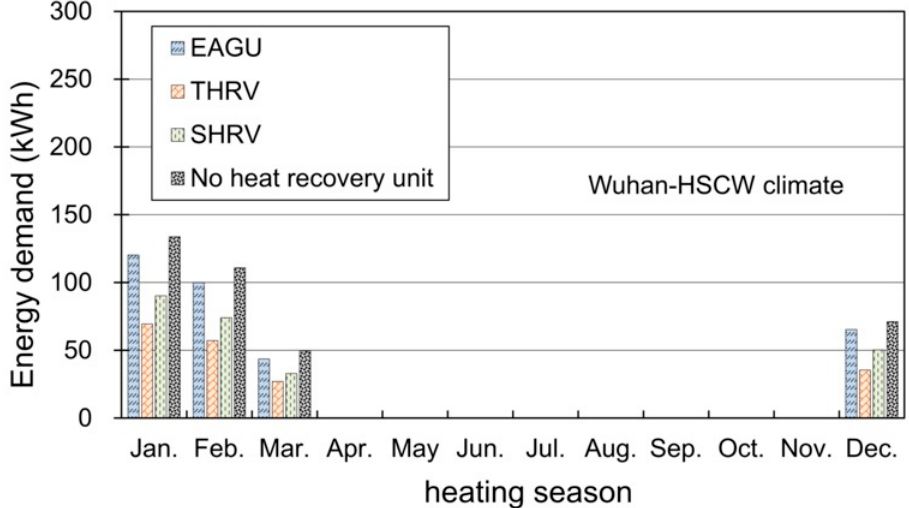
Figure 9. Monthly energy demand of the four cases in the heating season.